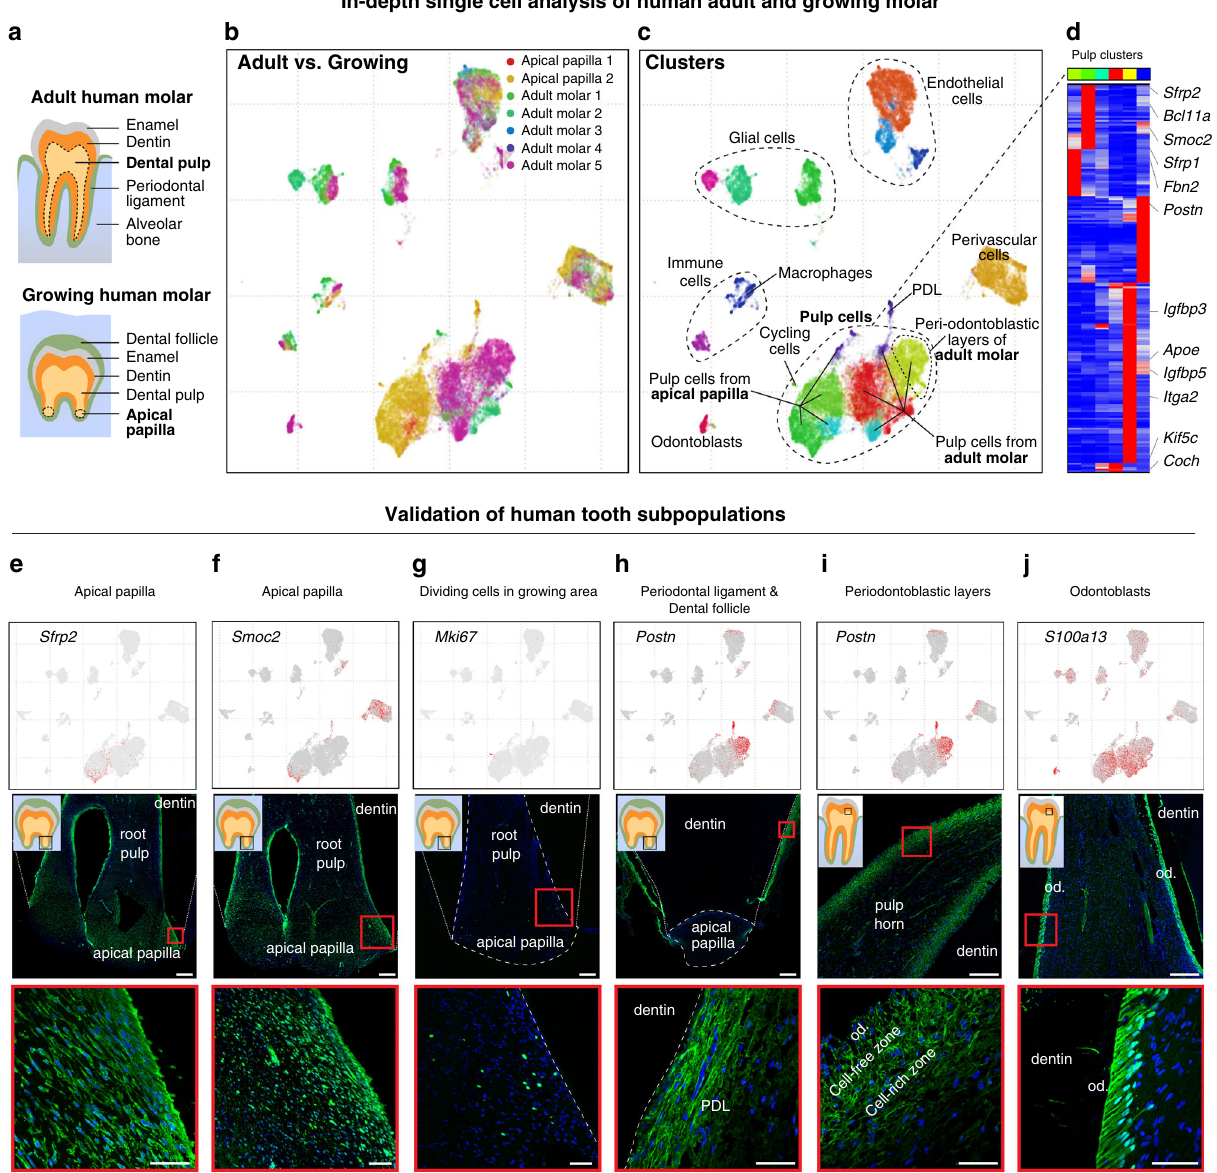
Fig. 8 Single-cell analysis of human adult and growing teeth. a Scheme of pulp regions isolated for single-cell RNA-seq from adult human molars and apical papillae of growing human molars (dotted regions). b Characterization of cell composition across fi ve adult and two growing human molars using scVI deep learning framework. UMAP dimensionality reduction visualizes similarity of expression pro fi les of 39,095 single cells. Colors correspond to individual datasets and indicate clustering by cell types. c Characterization of dental cell types in human teeth. Colors demonstrate 17 clusters as de fi ned by leiden clustering. Major clusters are de fi ned by expression of known markers. d Human dental pulp have at least six transcriptionally distinct states. Top color bar re fl ects colors of clusters shown in c ). Top 198 genes enriched in each cluster are shown (maximum to medium expression across clusters is at least four- fold and p value< 10 − 50 , one-way ANOVA test). e , f Identi fi cation of apical-like-mouse-incisor regions in the growing apical papilla of human molar shown by the expression of SFRP2 and SMOC2 (immunohistochemistry) in the growing region of apical papilla. g Dividing, MKI67 + cells are positioned in the growing part of the apical papilla. h , i Expression of POSTN shows very regionalized pattern in two main clusters: periodontal ligament (PDL) on the samples from apical papillae ( h ), but also demarcate the periodontal layers of adult dental pulp previously recognized as a cell-rich and cell-free zones ( i ). Immunohistochemical POSTN staining. j S100A13 was proposed as a marker of human odontoblasts. This gene is highly overexpressed in one of the subclusters, which is on t-SNE located in the close proximity to dental pulp. S100A13 was proved to be expressed in odontoblasts by immunohistochemistry. (Od. Odontoblasts; PDL periodontal ligament). Scale bars: 50 µ m, insets: 250 µ